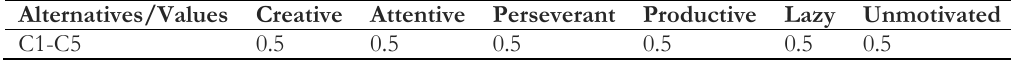
Table 7. Weights of alternatives for each criterion.